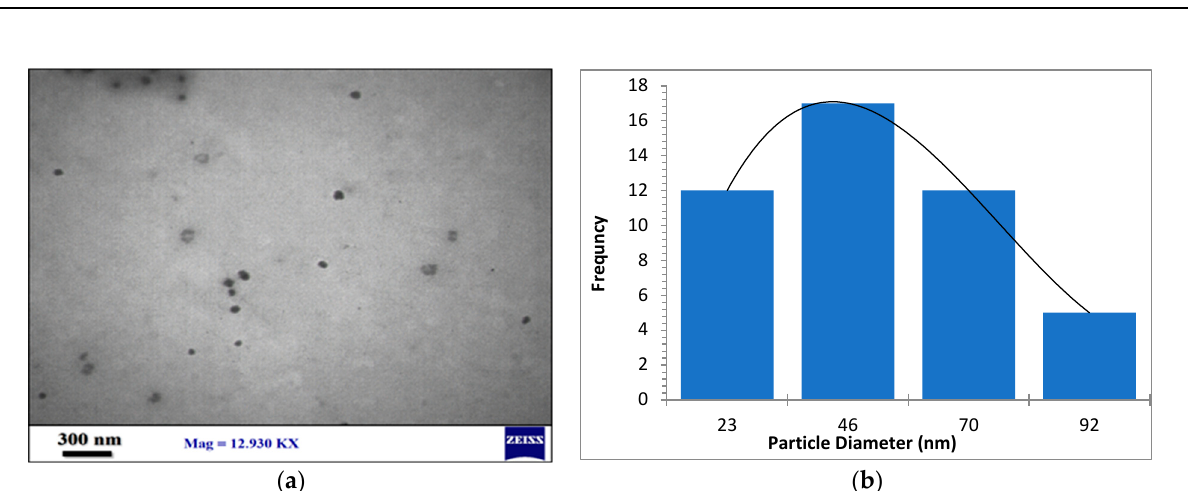
Figure 3. ( a ) TEM image of palladium nanoparticles (Pd NPs) prepared by pulsed laser ablation of palladium target in distilled water at 2.04 J/cm 2 , ( b ) size distribution.